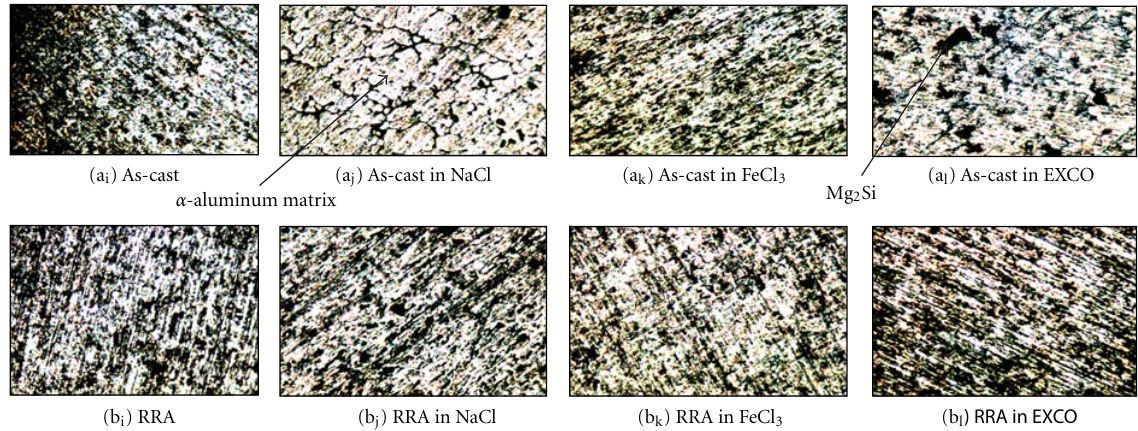
Figure 6: Micrographs of 0.42% Mg addition for untreated (a i –a l ) and treated (b i –b l ) specimens.